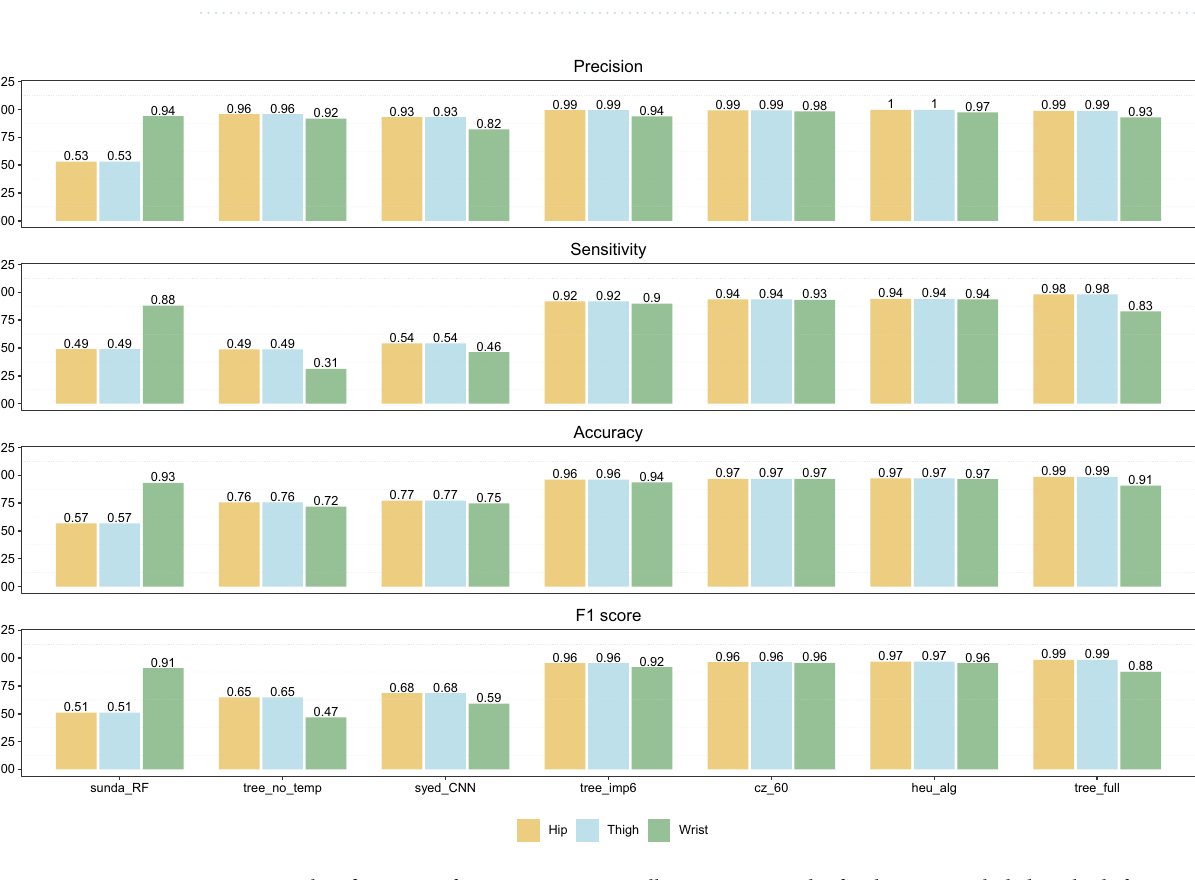
Figure 4. Visual example of the output of non-wear detection models and algorithms for a random person from the in-house wrist dataset (14 consecutive days). The light blue shade is ground-truth non-wear time. Syed_CNN , cz_60 , and tree_full are vertically offset for easier interpretation.